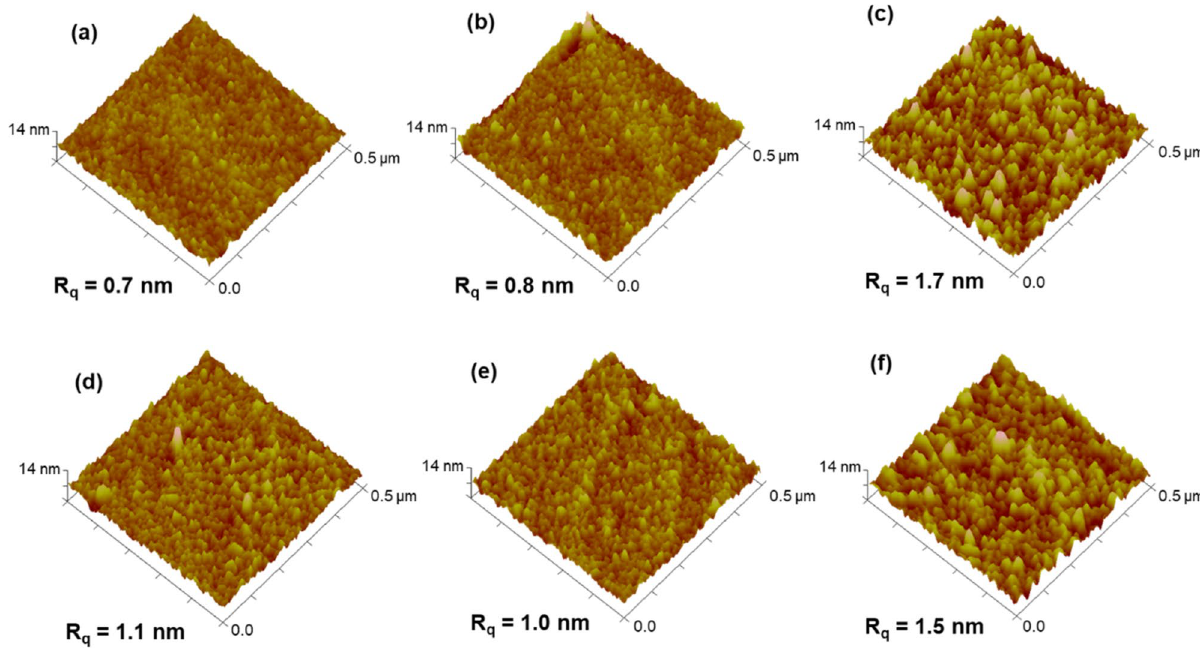
Figure 7. AFM 3D images of modified gold with ePDA ( a ), ePDA/ETA ( b ), ePDA-ETA ( c ), ePDA/IgG ( d ), ePDA/ETA/IgG ( e ) and ePDA-ETA/IgG ( f